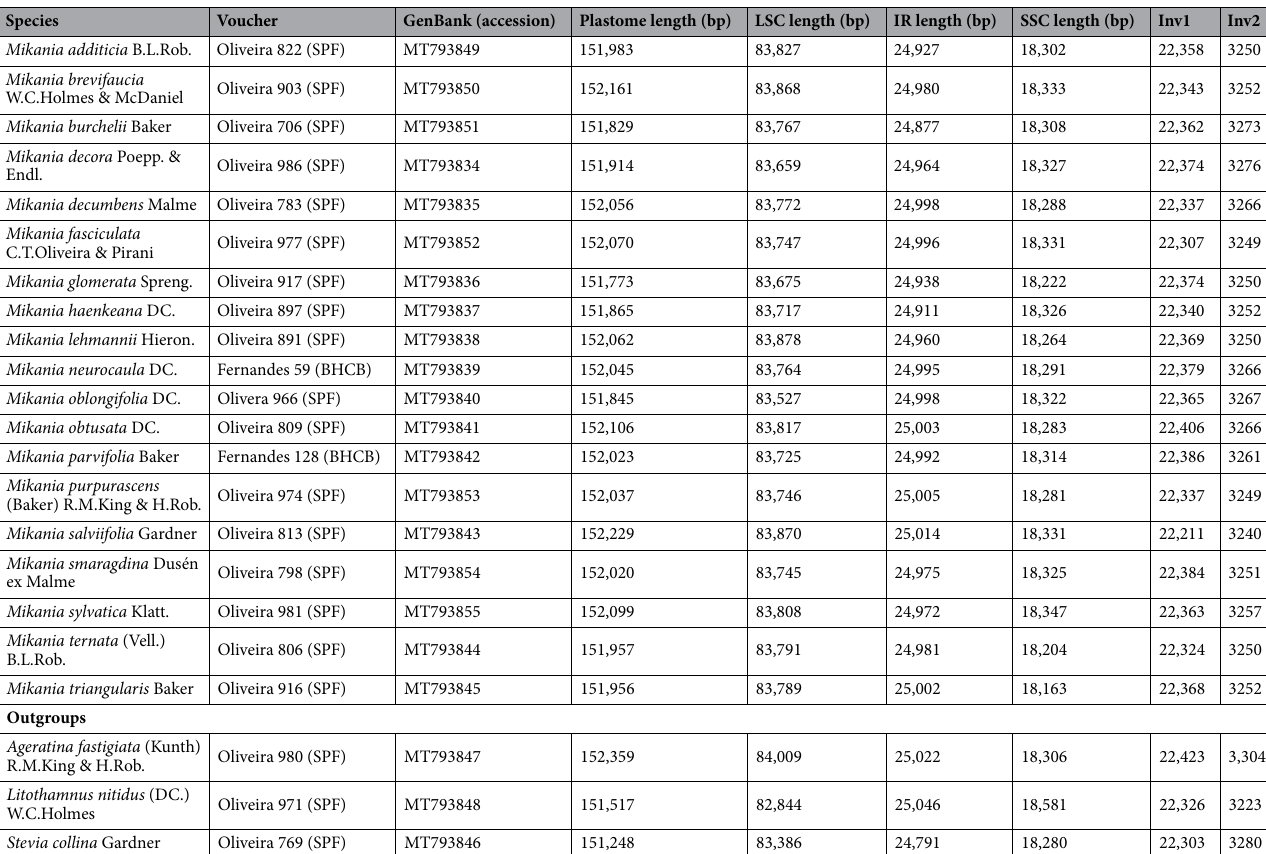
Table 1. Summary of the plastomes sequenced in this